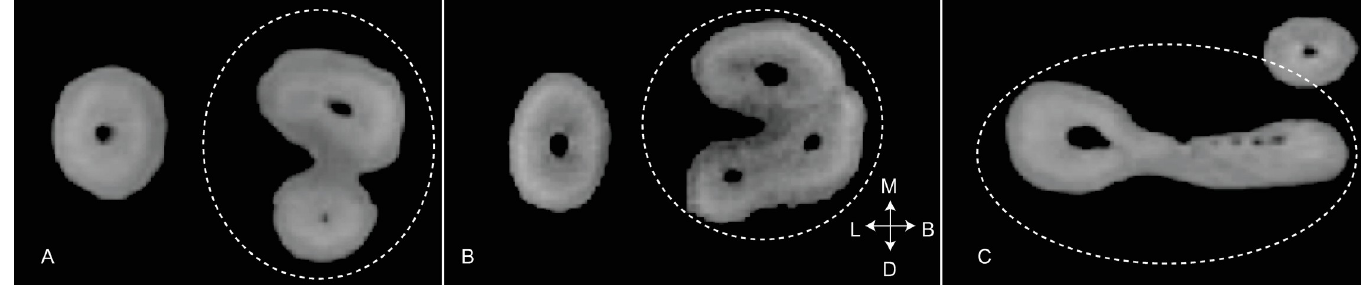
Fig 3. Fusion of multiple roots into right single roots in maxillary 2nd molars. A. fused mesial elliptical (E) and distal globular (G) root types. B. fused mesial E and distal hourglass (H) root types. C. fused lingual G and distal plate (P) root types. Images A, B, and C from the Root Canal Anatomy Project https://rootcanalanatomy. blogspot.com/ (accessed 10 March 2020).